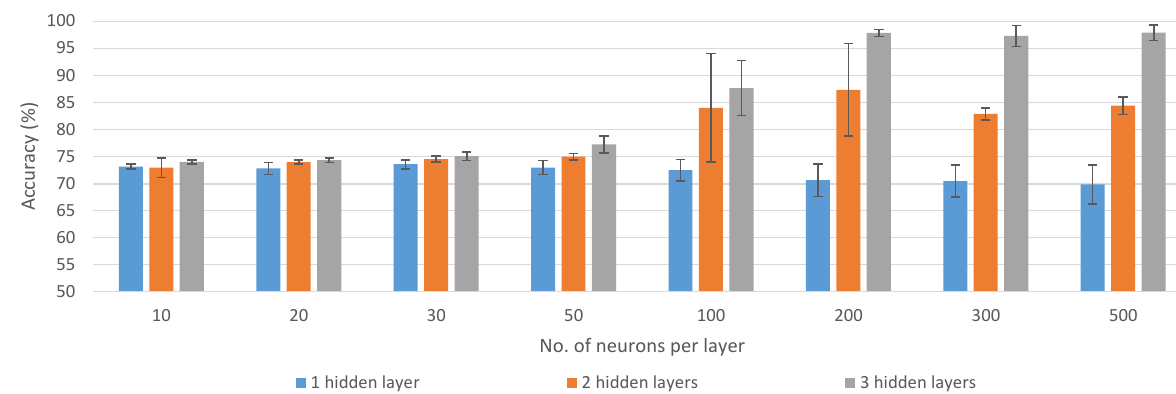
Figure 2. Average of the results obtained with the accelerometer dataset over the different cross-validation folds for each of the analyzed configurations.